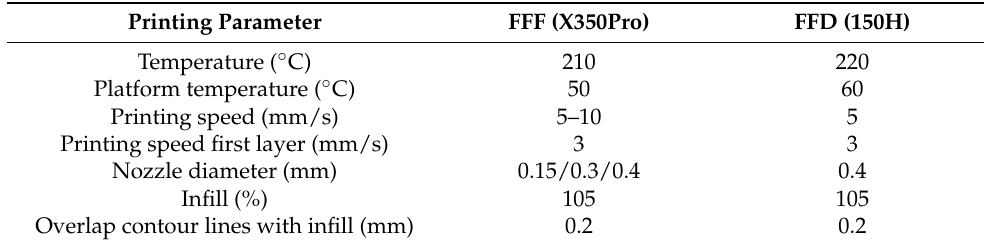
Table 5. FFF and FFD printing parameters for the selected PEG (8000)60/PMMA40 applying both PAT surfactants (solid load 60